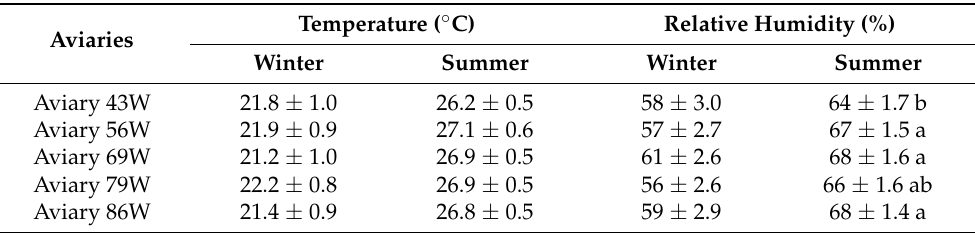
Table 1. Average daily air temperature ( ◦ C) and relative humidity (%) inside the laying hens’ aviaries in winter and summer.